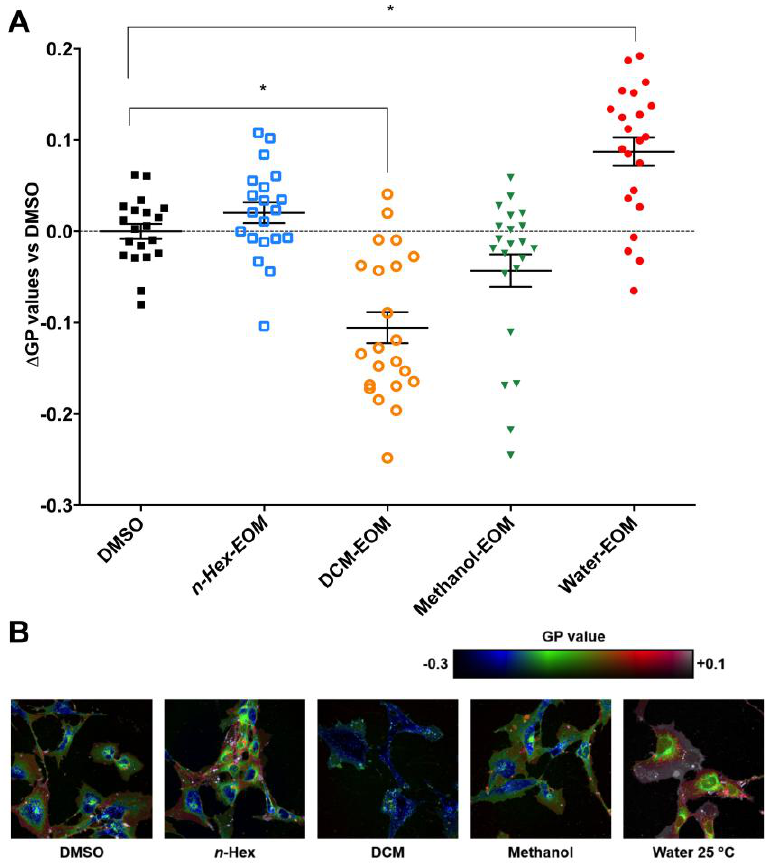
Figure 6. Effects of DEP-EOM on membrane-microstructure. ( A ) Cells were exposed to one of the four fractions at concentrations corresponding to 5 µ g/mL of the original DEPs or vehicle control (DMSO). After 30 min exposure, cells were fixed and stained for membrane order with the fluorescence dye di-4-ANEPPDHQ; ( B ) Confocal image of HMEC-1 cells (400 × magnification) stained with di-4-ANEPPDHQ, representative for three experiments. The results are expressed as mean ± SEM ( n = 3). * Significant difference from DMSO ( p < 0.05).